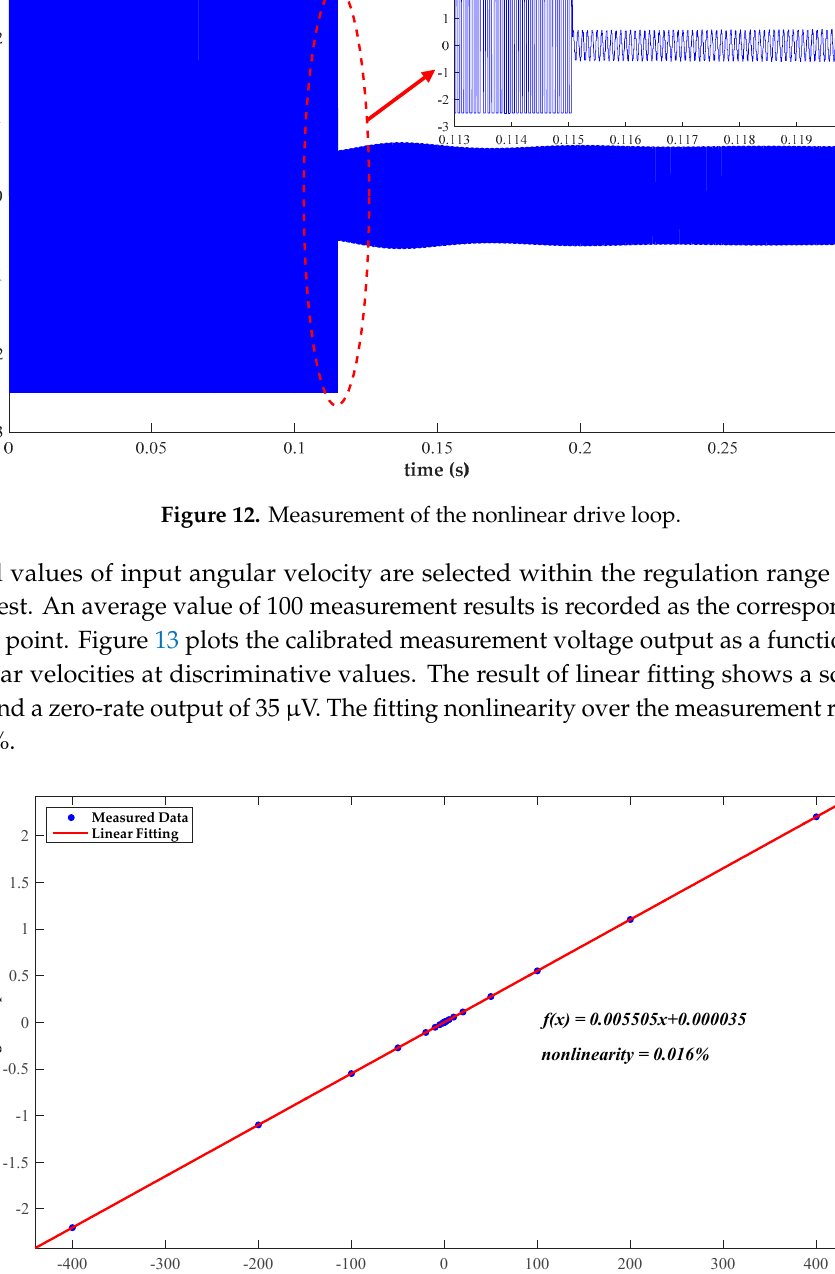
Figure 14. Standard Allan variance at 25 °C. Noise floor within a bandwidth of 60 Hz at the analog output is measured by a dynamic analyzer, as shown in Figure 15. Only power line interference remains in the measurement band. The 5 μ V/ √ Hz noise floor indicates an equivalent rate noise density no more than 0.0009 °/s/ √ Hz.